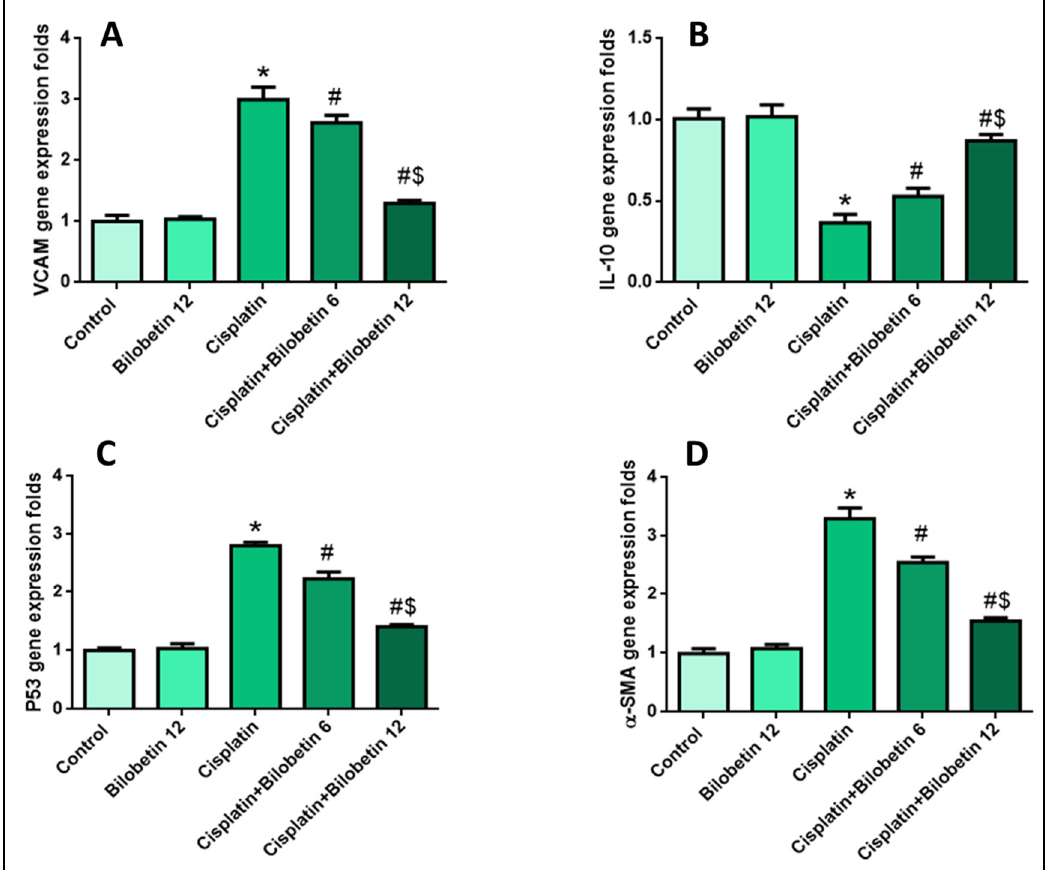
Figure 3. Effects of Bilobetin treatment on ( A ) VCAM gene expression level, ( B )IL-10 gene expression level, and ( C ) P53 gene expression level. ( D ) α -SMA gene expression level. CP-induced testicular damage was induced by a single i.p. injection of CP 7 mg/kg on day 3. Rats were grouped randomly into the control group. Bilobetin group was administered Bilobetin (12 mg/kg) i.p. daily for ten days; untreated CP group and CP groups were treated with Bilobetin (6, and 12 mg/kg respectively) i.p. daily for ten days and a single dose of i.p. injection of CP 7 mg/kg at day 3. Data expressed as mean ± SD ( n = 8/group). Significant difference vs. * respective control; # respective CP group; $ respective CP+ Bilobetin 6 group each at p ˂ 0.05.